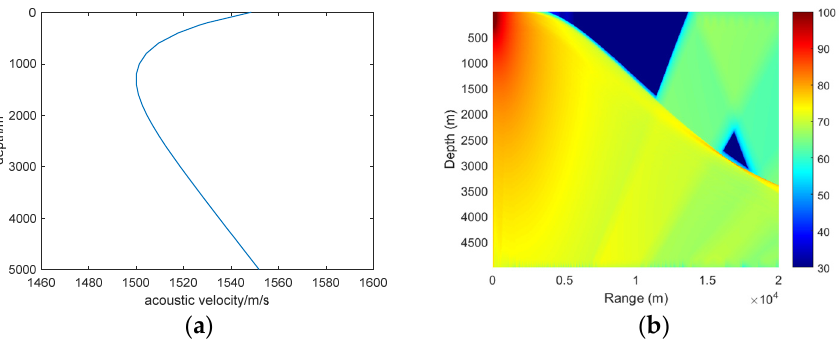
Figure 7. Deep-sea sound scattering field calculation results: ( a ) Deep-sea sound velocity profile of South China Sea; ( b ) Sound scattering field calculation results.